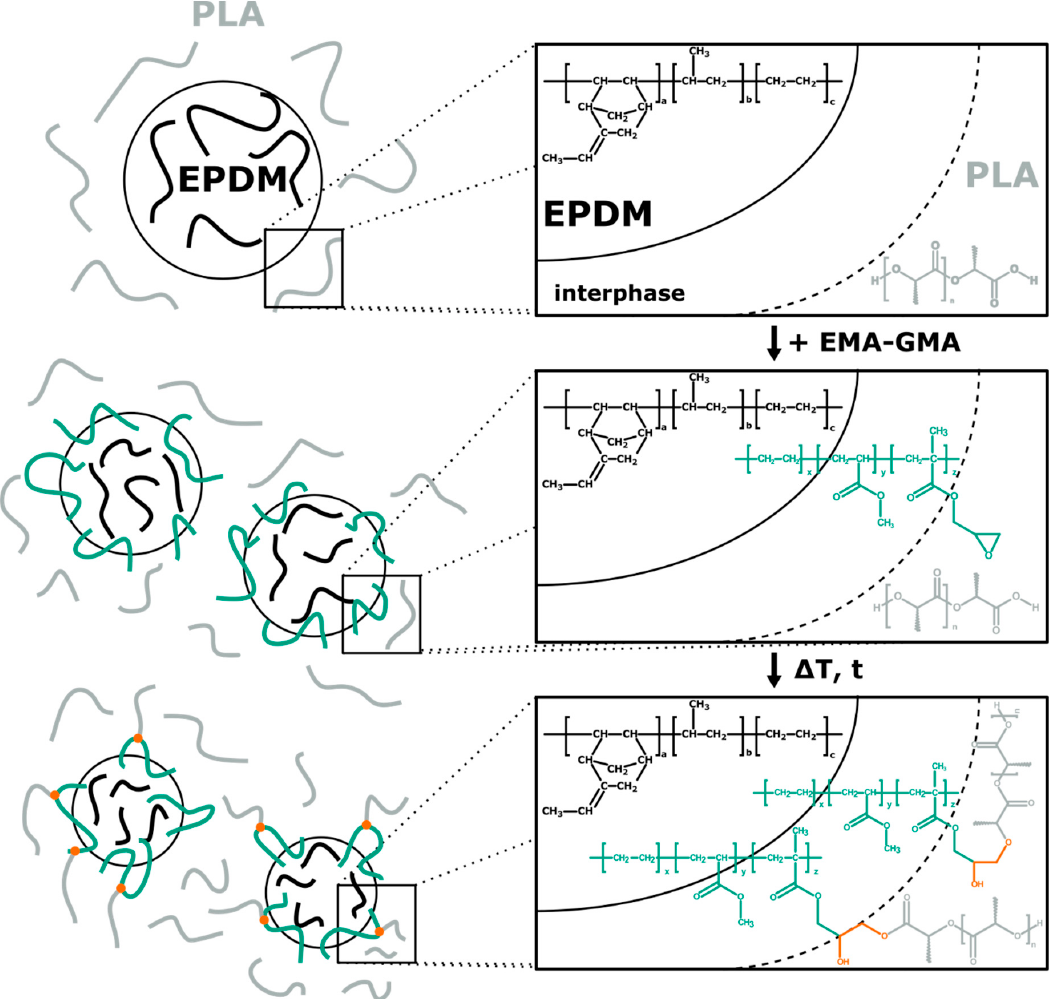
Figure 1. Schematic representation of physical compatibilization of PLA and EPDM with EMAGMA and possible chemical reactions.